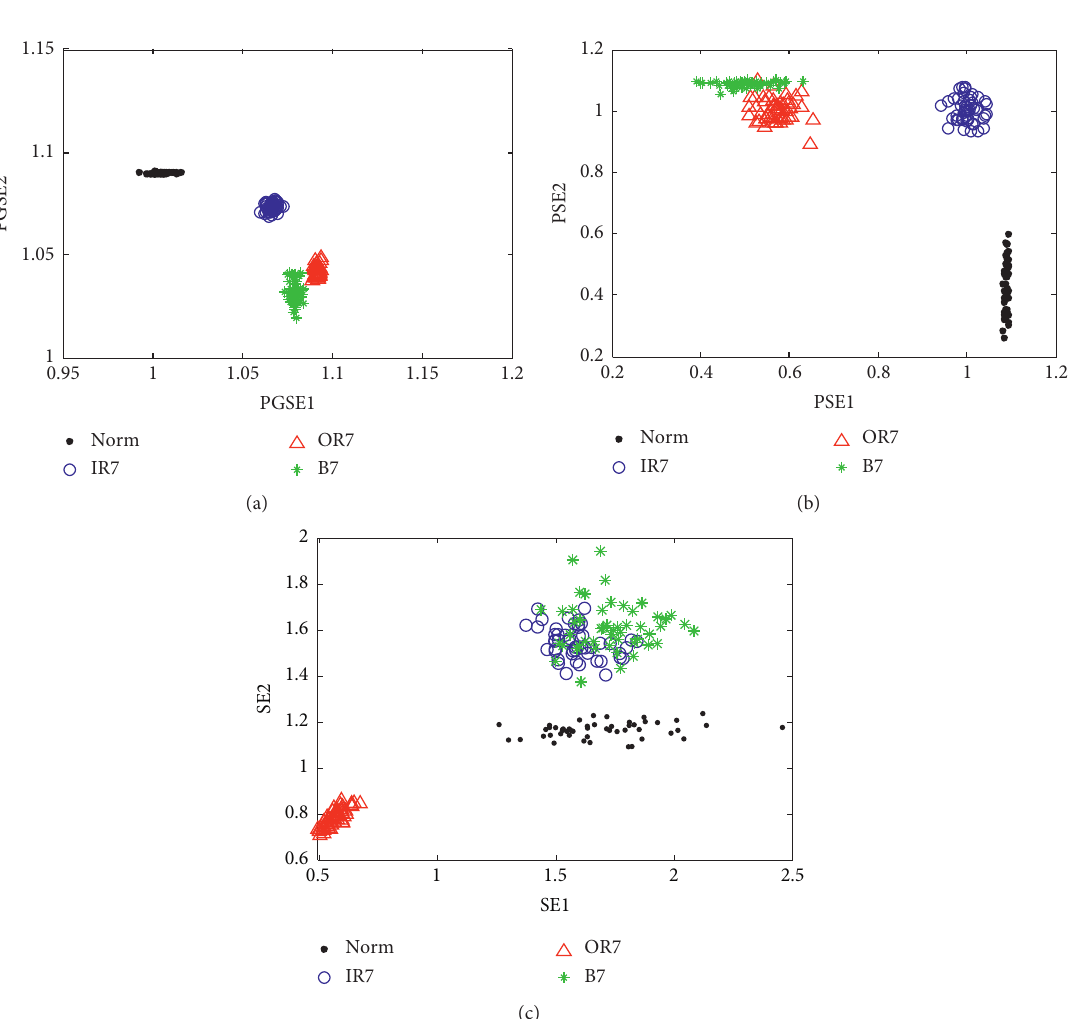
Figure 21: The plotting of the best two features selected by LS in case 1. (a) MPGSE and LS, (b) MPSE and LS, and (c) MSE and